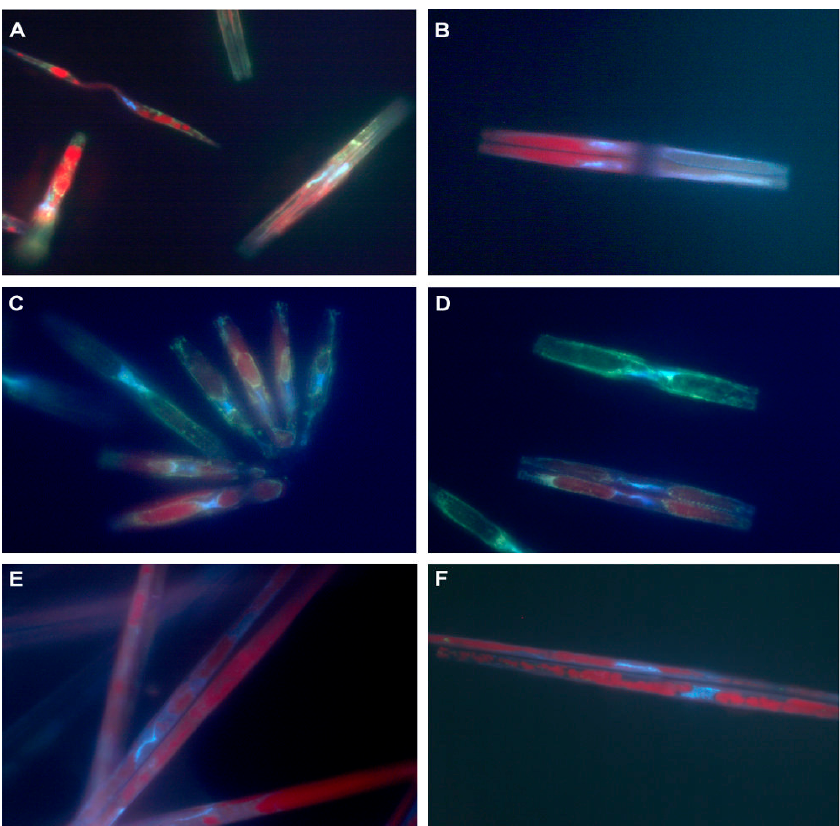
Figure 3. The microphotographs of DAPI ‐ stained F. radians cells. ( A ) and ( B ) strain G9, February 2011; ( C ) strain G9, July 2012; ( D ) strain G9, October 2012; ( E ) and ( F ) strain Ax BK280, 2017. Blue: DAPI specifically binding to DNA and nonspecifically binding to polysaccharides; red: chloroplast autofluorescence; yellow: DAPI nonspecifically binding to polyphosphates. Green fluorescence is produced by a mixture of DAPI ‐ stained polysaccharides and polyphosphates.